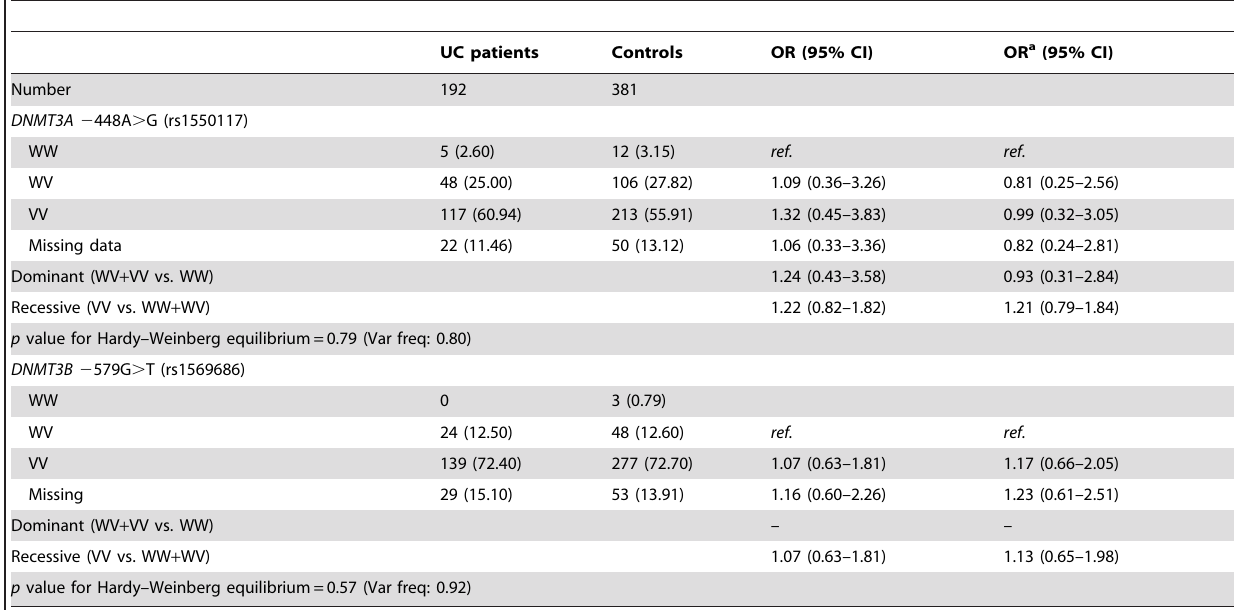
Table 3. Odd ratios of UC risk were evaluated by using simple and multivariate logistic regression models by stratification